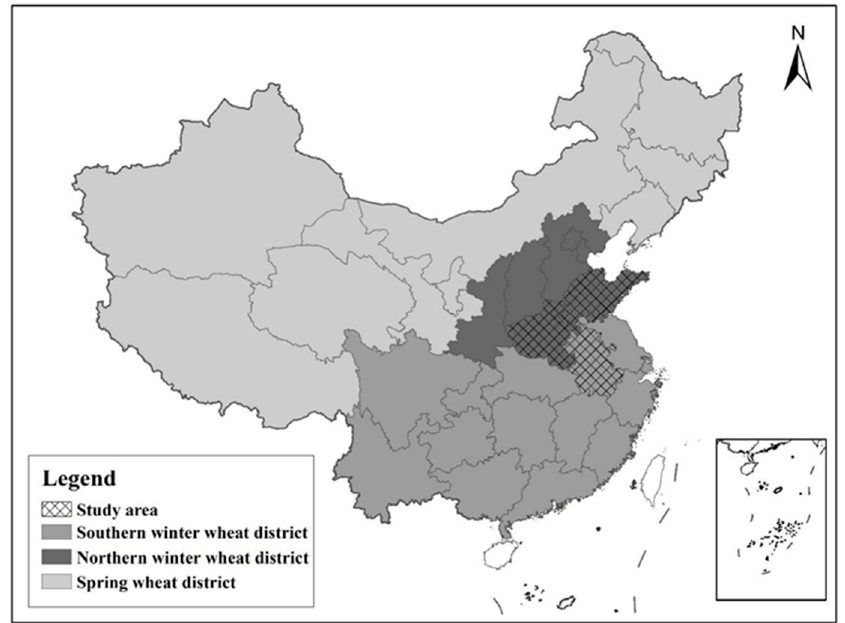
Figure 2. Study area and three wheat production districts in China.